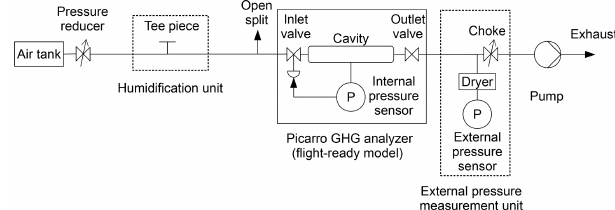
Figure 2. Experimental setup for water correction experiments with humidification via water droplets and external pressure monitoring. Here, the setup for a flight-ready analyzer is shown.